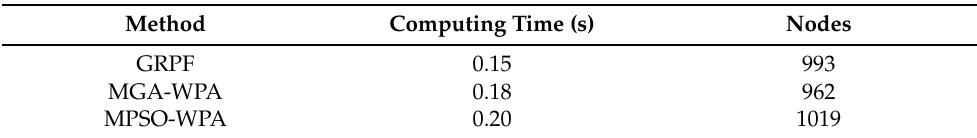
Table 3. Computing times and numbers of generated nodes in the stability tests of the considered fractional-order digital filter.